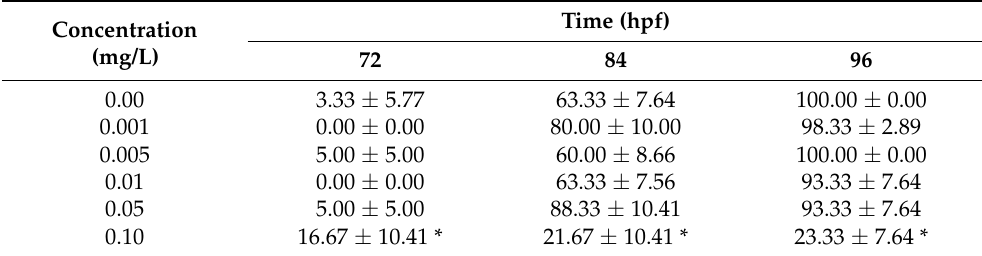
Table 4. Cumulative hatching rate of embryos after exposure to different concentrations of Hg 2+ .